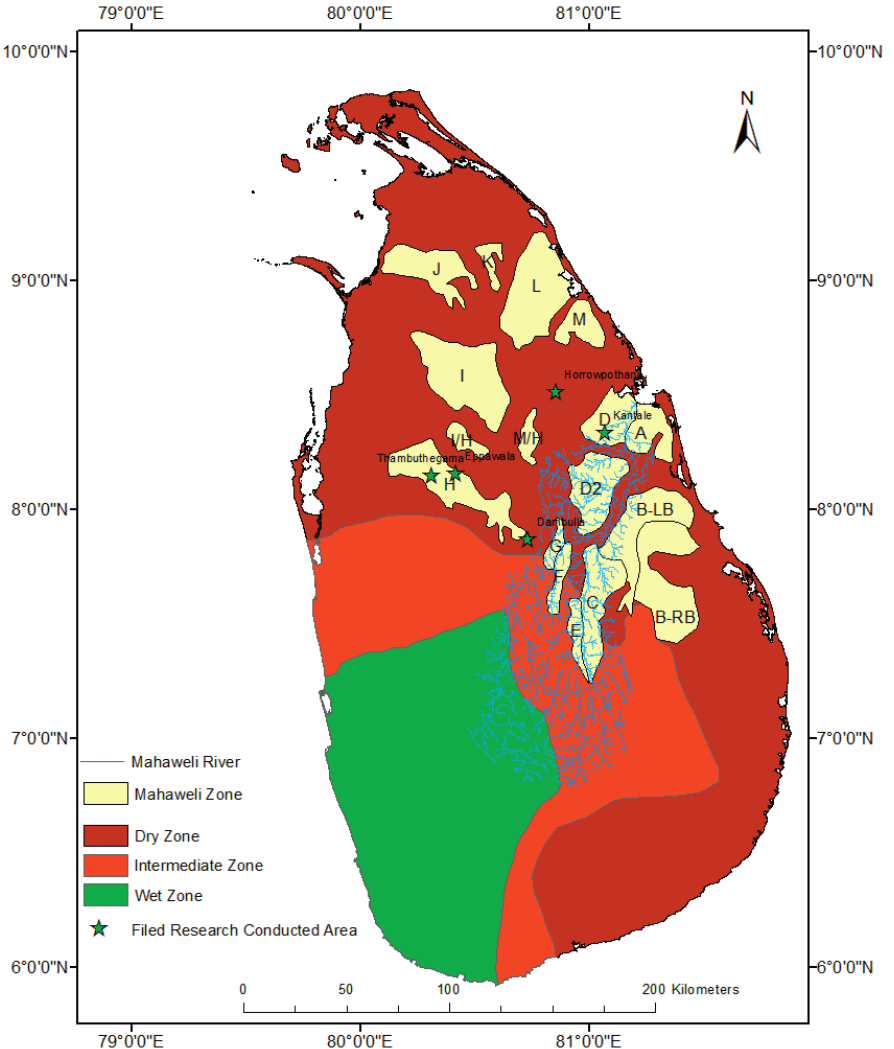
Figure 1. Climate zones and irrigated regions (irrigation systems/zones) in the Mahaweli Development Program, and areas where field research was conducted (authors’